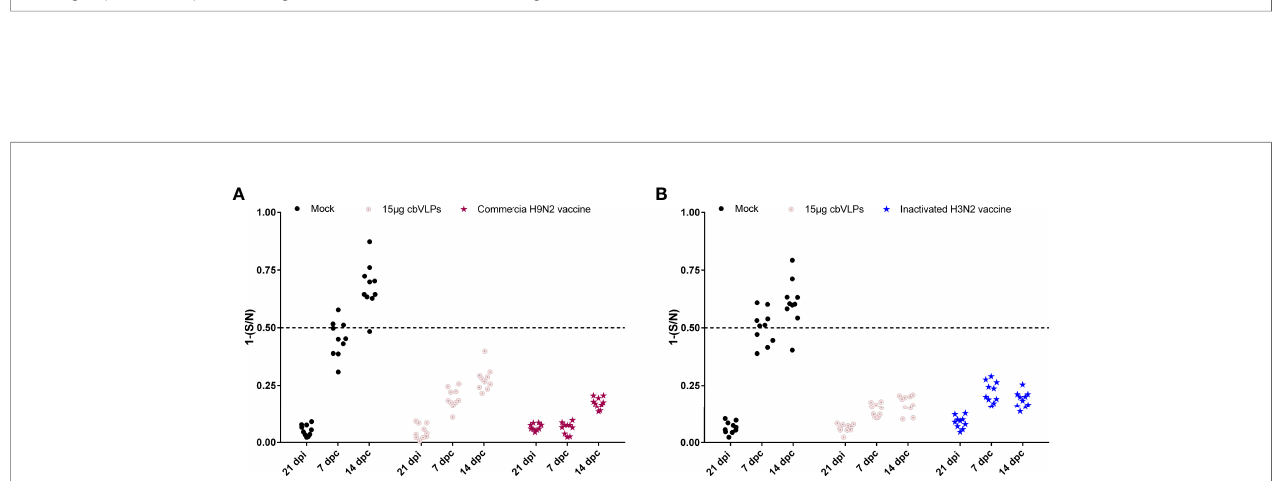
FIGURE 7 | Immunohistochemistry analysis of tissue samples from immunized chickens intranasally inoculated with H9N2 or H3N2 AIV strains on 7 days post challenge. Panels (A – F) indicate those trachea and lungs from the groups of mock, 15 m g cbVLPs and commercial H9N2 vaccine after H9N2 challenge. Panels (G – L) indicate those trachea and lungs from the groups of mock, 15 m g cbVLPs, and inactivated H3N2 vaccine after H3N2 challenge. Only the trachea and lungs in the mock groups showed positive antigens for H9N2 or H3N2 AIVs. Magni fi cation: 20×.